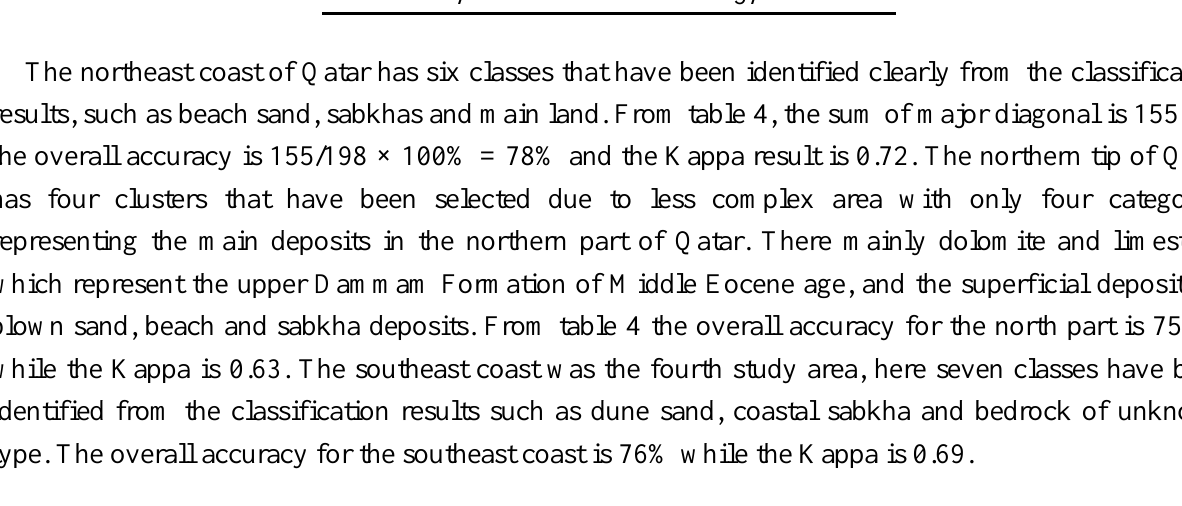
Table 4. An error matrix showing row, column and grand total, for the studied area in the northern tip of Qatar